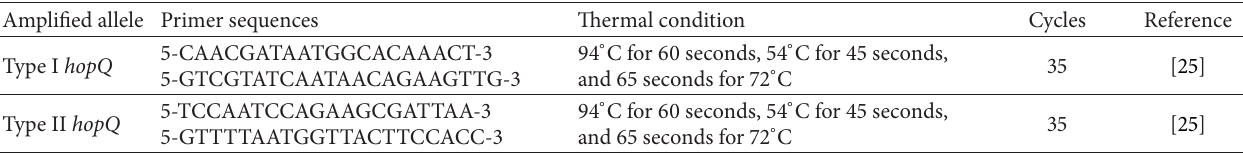
Table 1: Primer sequences, PCR condition.